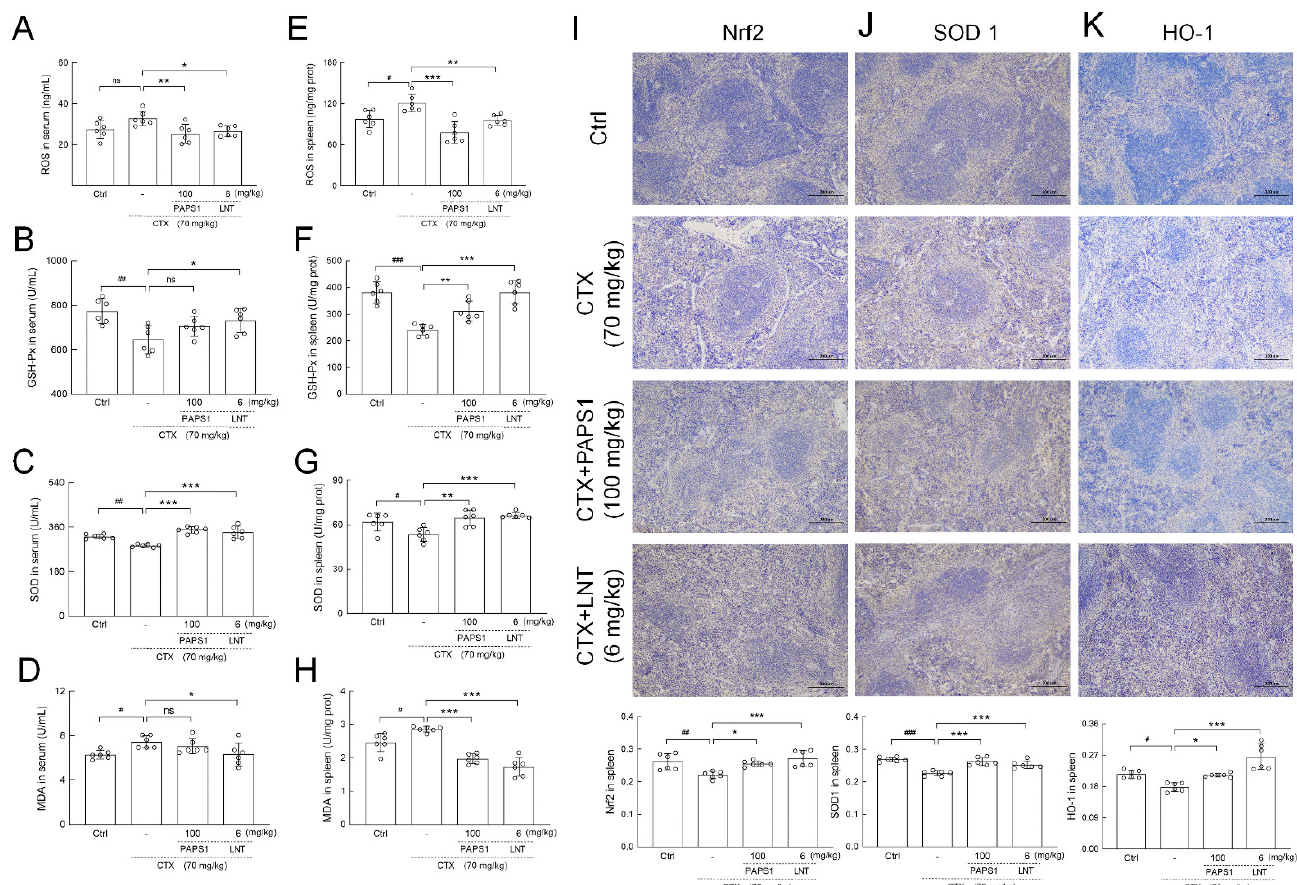
Figure 7. PAPS1 regulated the levels of oxidative stress indices and expressions of Nrf2 and its downstream proteins in the serums and spleens of CTX-immunosuppressed mice. The levels of ( A ) ROS, ( B ) GSH-Px, ( C ) SOD and ( D ) MDA in the serums and the levels of ( E ) ROS, ( F ) GSH-Px, ( G ) SOD and ( H ) MDA in the spleens were measured. Immunohistochemical staining of ( I ) Nrf2, ( J ) SOD1 and ( K ) HO-1 in the spleens of mice (magnification: 100×, scale bar: 200 μ m). Data are presented as the mean ± S.D. ( n = 6) and were analyzed via a one-way ANOVA test followed by Dunn’s multiple comparisons post hoc tests. ns > 0.05, # p < 0.05, ## p < 0.01 and ### p < 0.001, compared with Ctrl mice; ns > 0.05, * p < 0.05, ** p < 0.01 and *** p < 0.001, compared with CTX-only treated mice. The height of the column chart represents the means, and the circle represents the independent sample value within each group. Ctrl, control , CTX, cyclophosphamide; PAPS1, water-soluble PA polysaccharides, LNT, lentinan; Nrf2, nuclear factor erythroid 2-related factor 2; ROS, reactive oxygen species; GSH-Px, glutathione peroxidase; SOD, superoxide dismutase; MDA, malondialdehyde; SOD1, superoxide dismutase 1; HO-1, heme oxygenase 1.